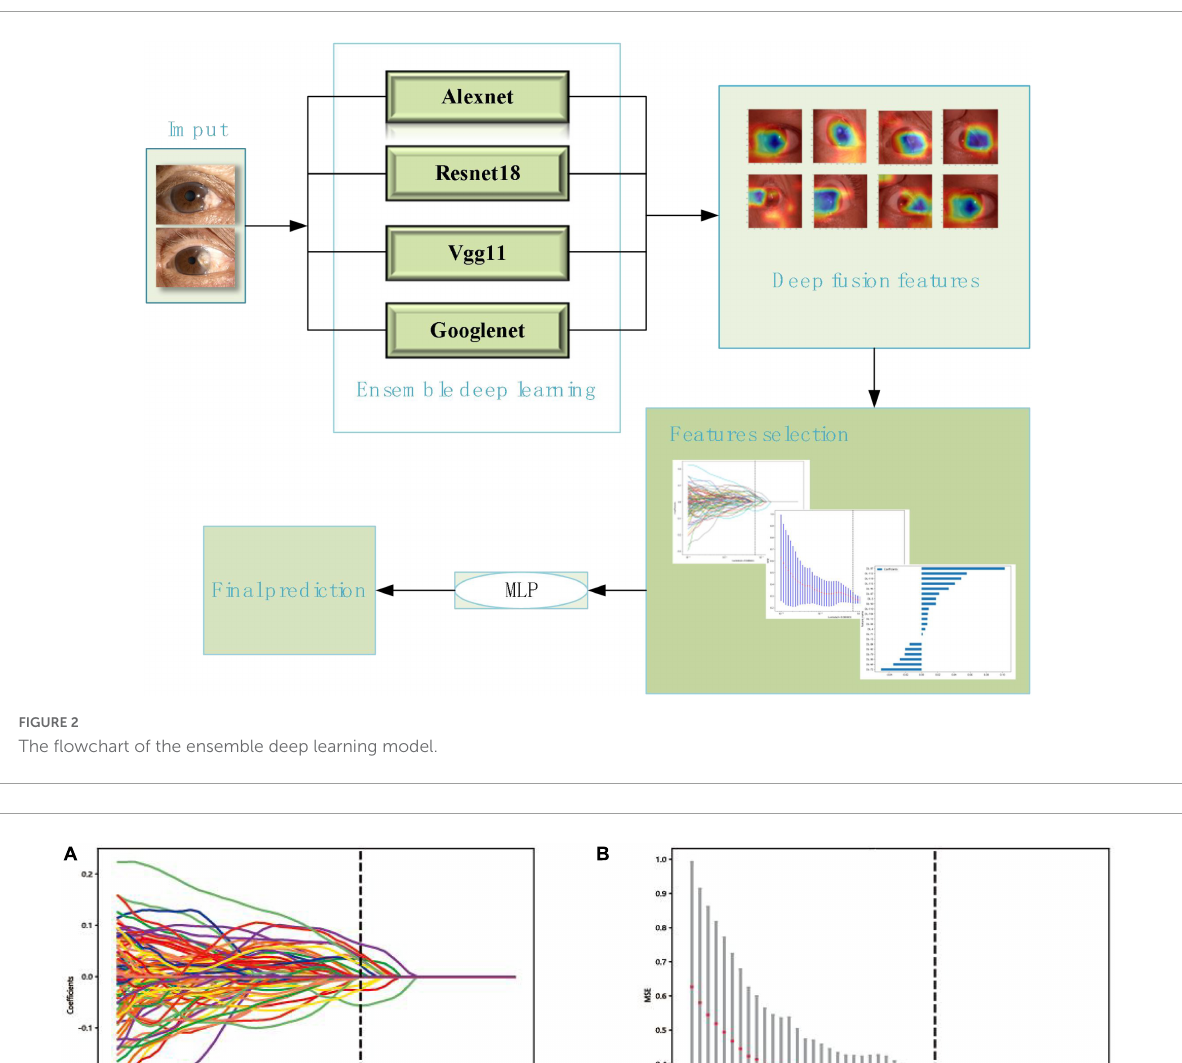
FIGURE3 Feature selection in the least absolute shrinkage selection operator (LASSO) model: (A) LASSO coefficient profiles of the features. (B) Selection of tuning parameters in the Lasso regression analysis by 10-fold cross-validation.